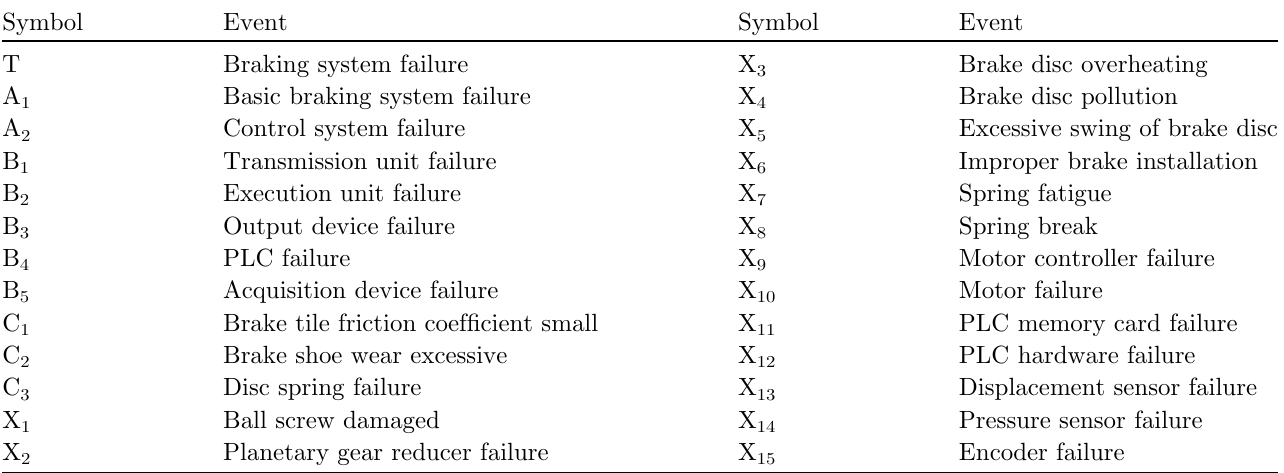
Table 1. Fault tree nodes.